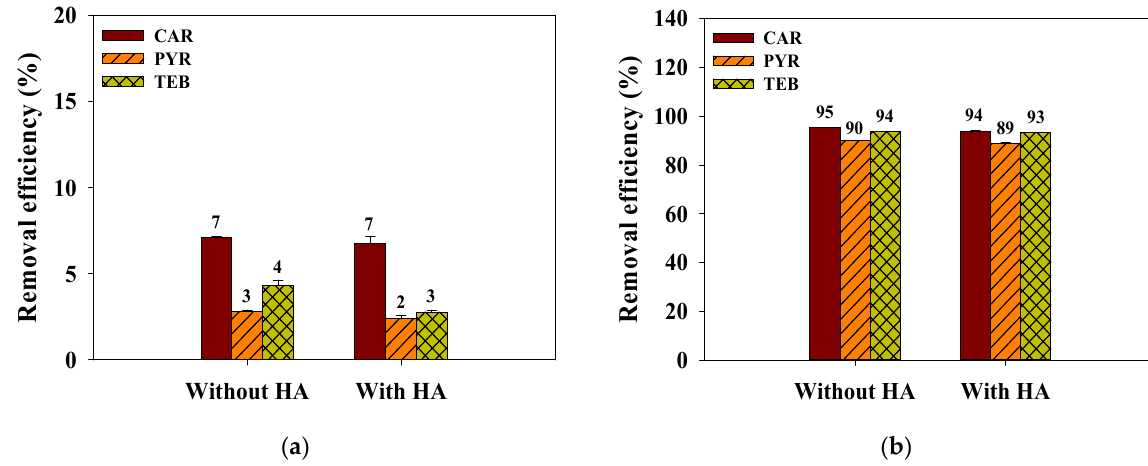
Figure 10. Effects of humic acids (HA) on the adsorption of the fungicides by ( a ) PSB and ( b ) PSB OX-A (the concentration of HA = 5 mg L − 1 , agitation speed = 150 rpm; contact time = 24 h; absorbent dosage = 50 mg L − 1 ; initial concentration of each fungicide = 10 μ M; temperature = 25 °C; pH = 7.0).